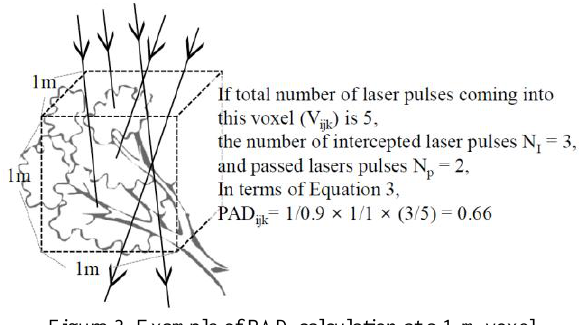
Figure 3. Example of PAD calculation at a 1-m voxel